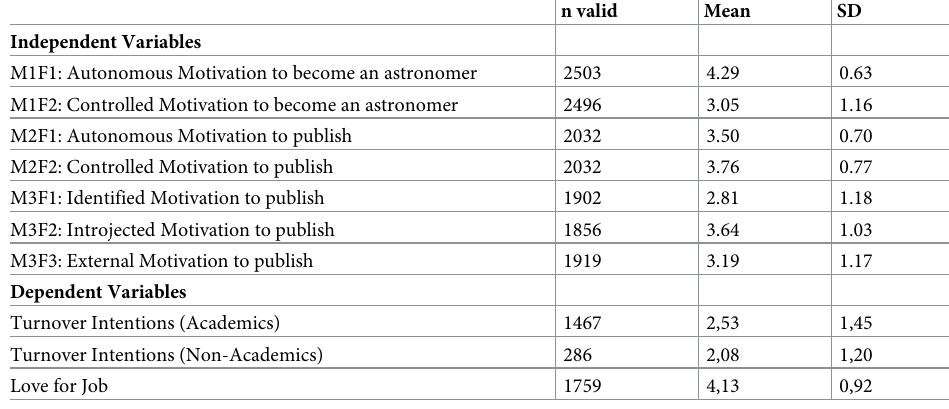
Table 1. Means and standard deviations of the independent variables—The factors of the motivation constructs “Motivation to become an Astronomer” (M1), “Drivers to Publish” (M2) & “Feelings when failing to Publish” (M3)—And dependent variables—Turnover intentions & love for job.